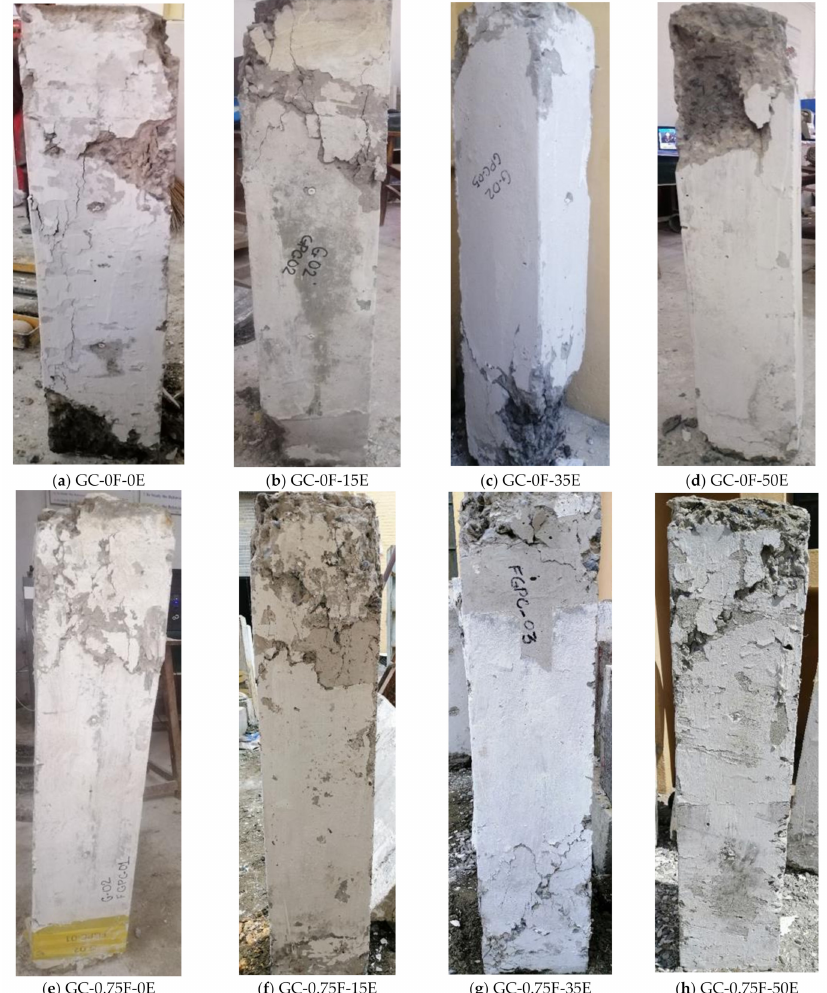
Figure 7. The failure mode of GC columns after the